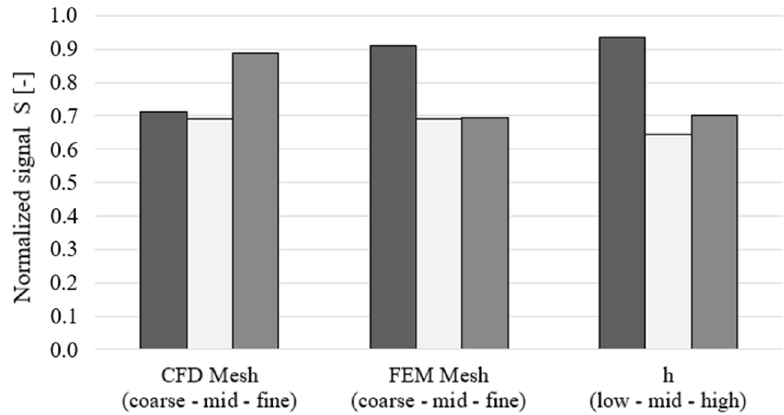
Figure 13. Normalized signal S dependence from factor levels in the Orthogonal Array.